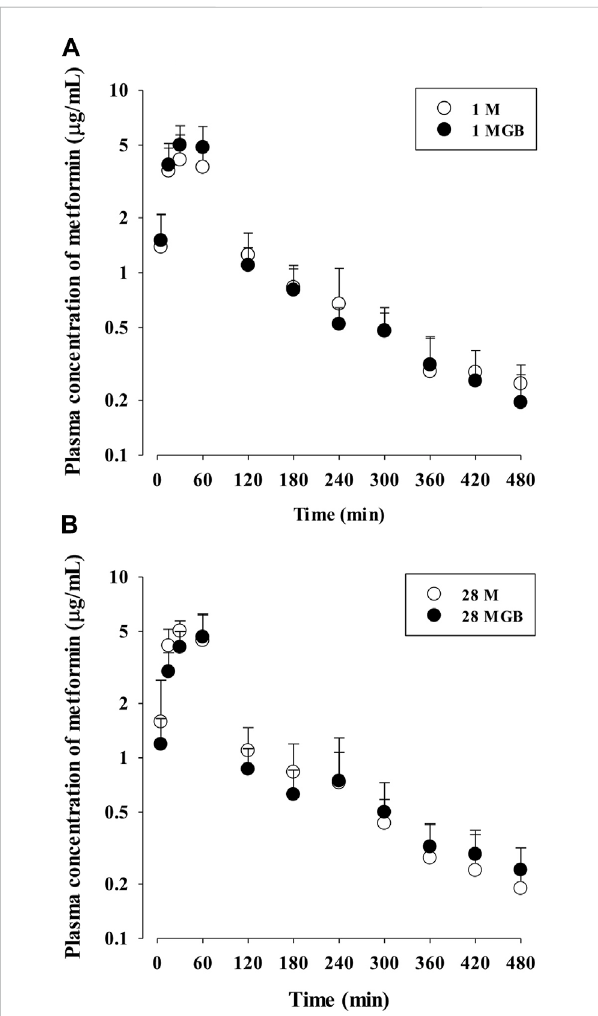
FIGURE 2 Themeanplasmaconcentration-timepro fi lesofmetforminafter oral administration of metformin with ( C ; 1 MGB and 28 MGB) and without GB ( ○ ; 1 M and 28 M) to mice, respectively. The doses of metformin and GB were 50 and 200 mg/kg, respectively. Treatment periods were 1-day (A) and consecutive 28-day (B) ,